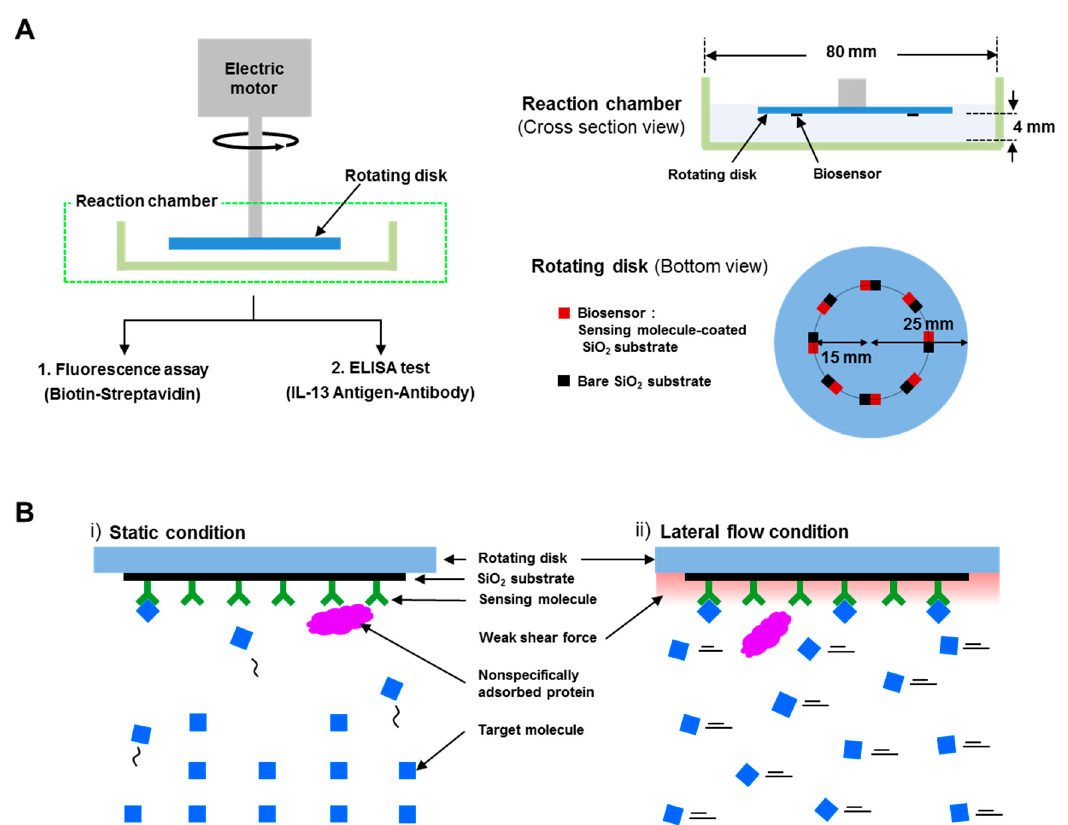
Figure 1 . ( A ) Schematic diagram of a high-speed lateral flow biosensing system; ( B ) Schematic diagrams depicting the motion of molecules near the surface of a biosensor under ( i ) static conditions and ( ii ) lateral flow conditions.